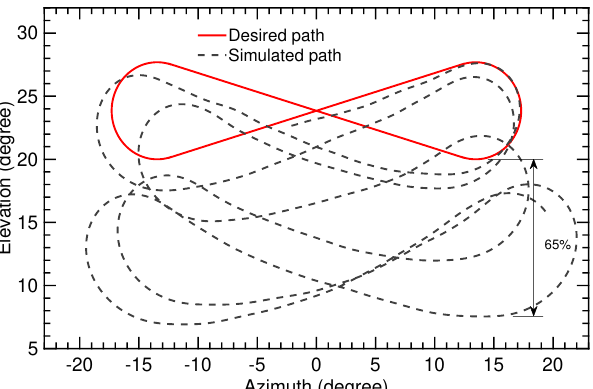
Figure 20. Trajectory computed on the basis of classical flight controller for flight time of 70